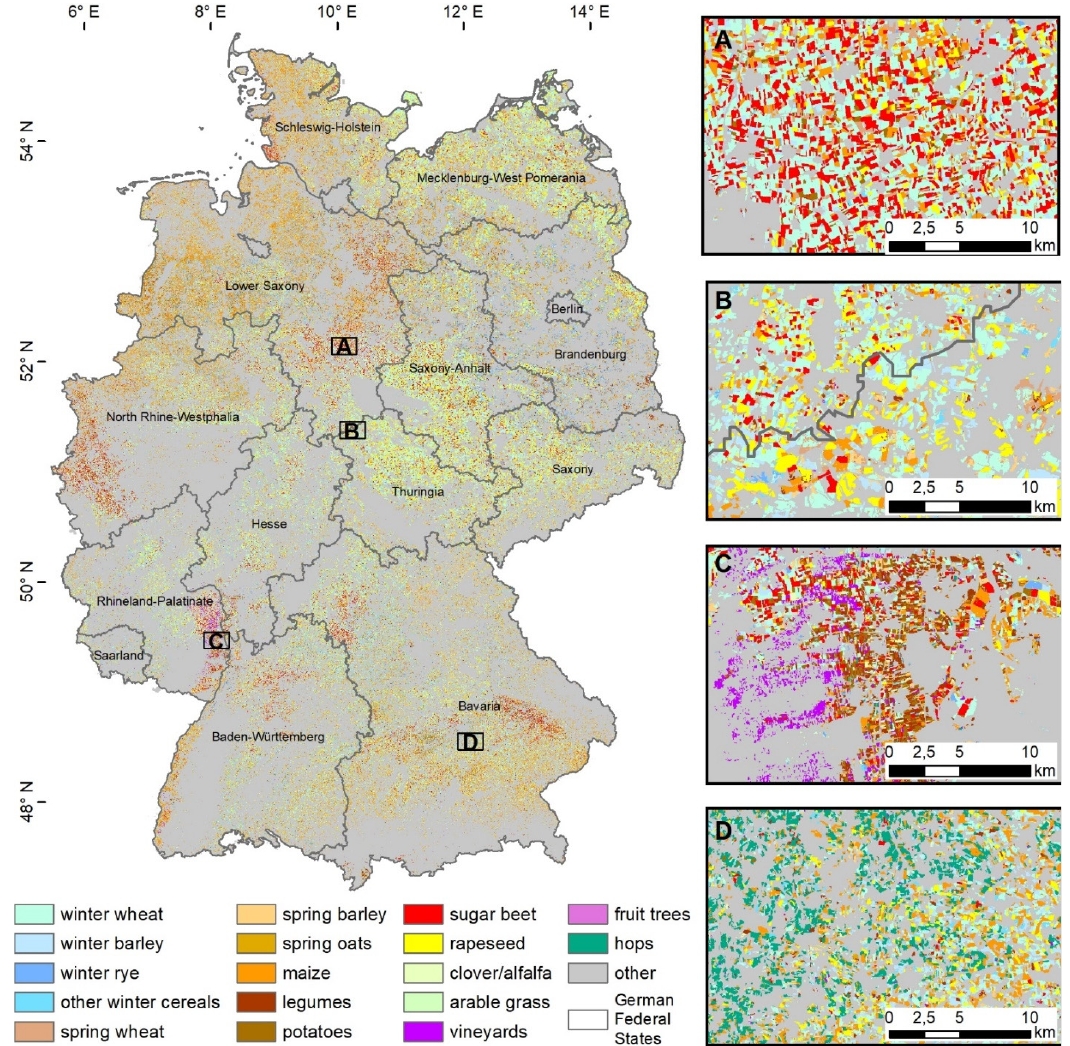
Figure 7. Crop type classification for Germany 2018 based on the S12 model. The class other comprises non-agricultural land use such as forest, urban, or water, as well as permanent grasslands. The subset maps show growing regions in ( A ) the very fertile and intensively used “Hildesheimer Börde” in Lower Saxony, ( B ) the “Eichsfeld” in the former border region of Eastern and Western Germany, ( C ) Rhineland-Palatinate west of Mannheim with a part of the “German Wine Route”, and ( D ) Bavaria between Ingolstadt and Landshut, the so-called “Hallertau” famous for hop production.